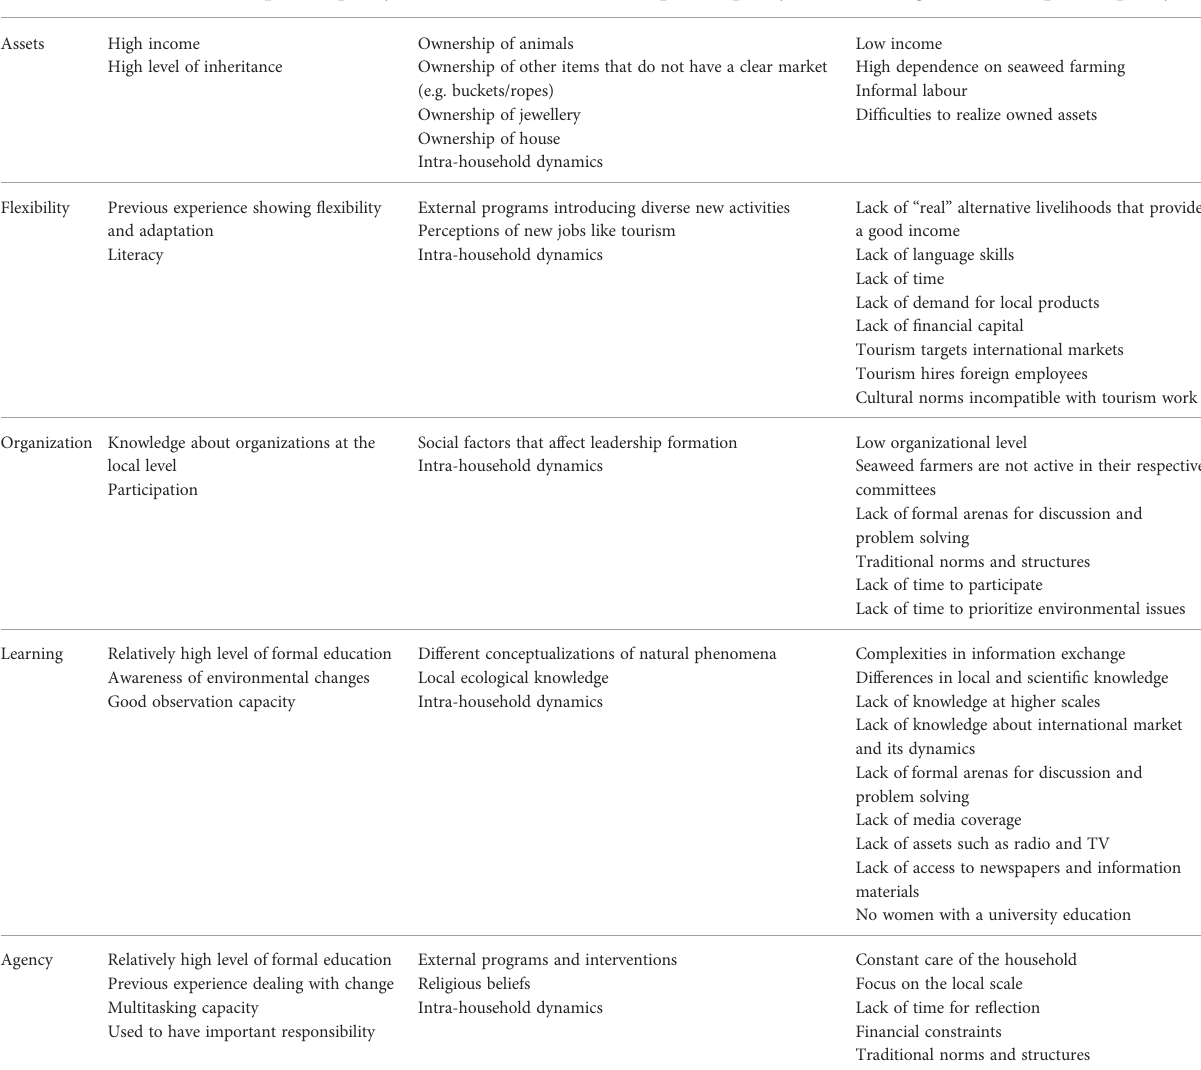
TABLE 3 Classi fi cation and summary of the results of women ’ s adaptive capacity in coastal Zanzibar, showing the fi ve domains of Cinner ’ s typology for Adaptive Capacity (Cinner et al., 2018).